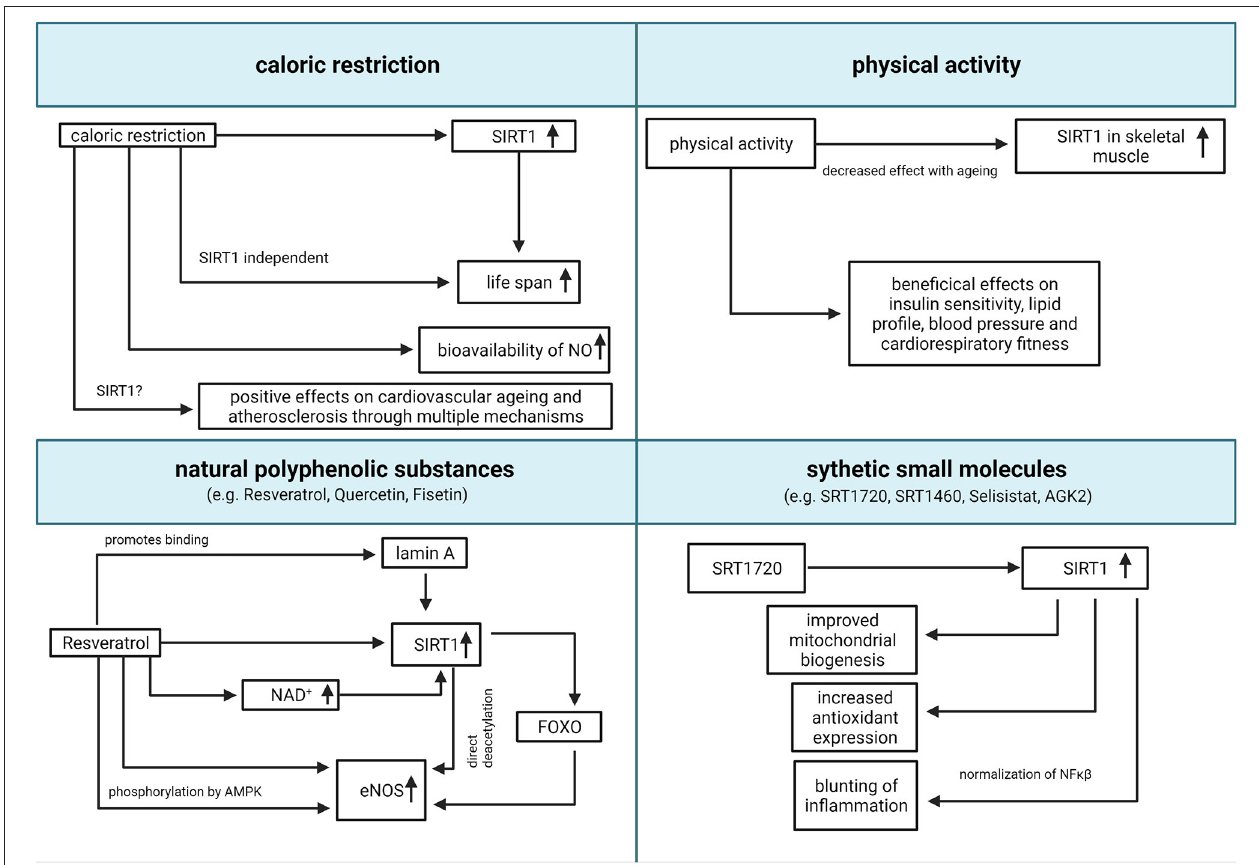
FIGURE 2 | Translational relevance of SIRT1. Summary of potential pharmacologic and non-pharmacologic interventions to increase SIRT1 activity (created with BioRender.com). eNOS, endothelial nitric oxide synthase; FOXO, forkhead box O class; NAD, nicotinamide adenine dinucleotide; NO, nitric oxide; SIRT1, Sirtuin 1; NF- κ B, nuclear factor kappa-light-chain-enhancer of activated B cells.